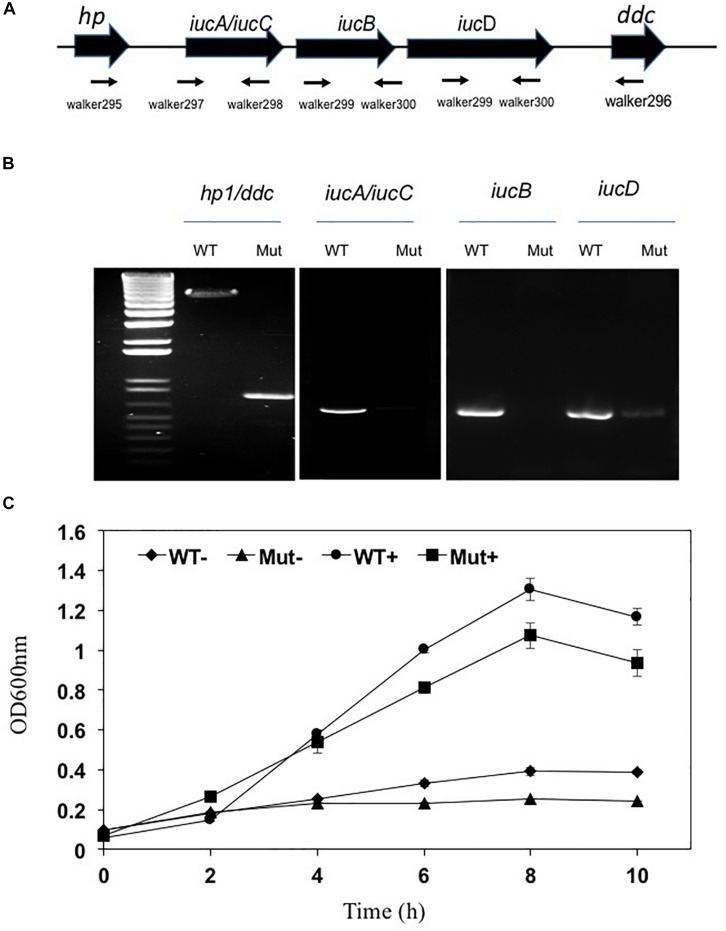
Deletion of the siderophore synthesis gene cluster (ΔiucA_iucC/iucB/iucD) led to impaired growth under iron stress conditions. (A) Organization of the iucA/iucC, iucB and iucD gene cluster was shown as the wide solid arrows (up panel). The locations and amplification directions of the primers were indicated using the thin arrows (low panel). hp, hypothetic protein; ddc, putative L-2,4-diaminobutyrate decarboxylase. (B) Detection of gene fragments of iucA/iucC, iucB and iucD genes in the WT and the mutant. Lane M, molecular marker. WT, wild-type; Mut, mutant. (C) The growth curve of WT and siderophore synthesis mutant in high-iron and low iron media. WT−, wild-type grown in the low iron media; Mut−, mutant grown in the low iron media; WT+, wild-type grown in the high-iron media; Mut+, mutant grown in the high-iron media.